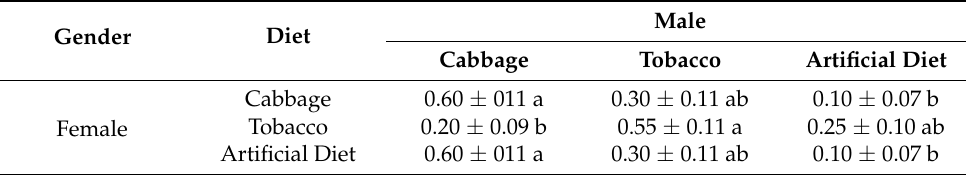
Table 3. Mate choices of females by